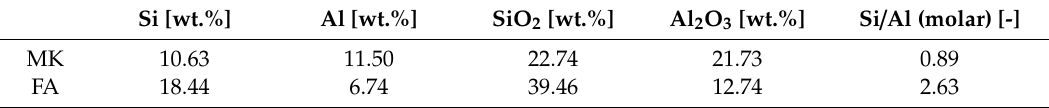
Table 2. Amorphous Si, Al, SiO 2 , Al 2 O 3 and molar Si/Al ratio of metakaolin (MK) and fly ash (FA), determined from powder X-ray di ff raction (XRD) and X-ray fluorescence (XRF) results.